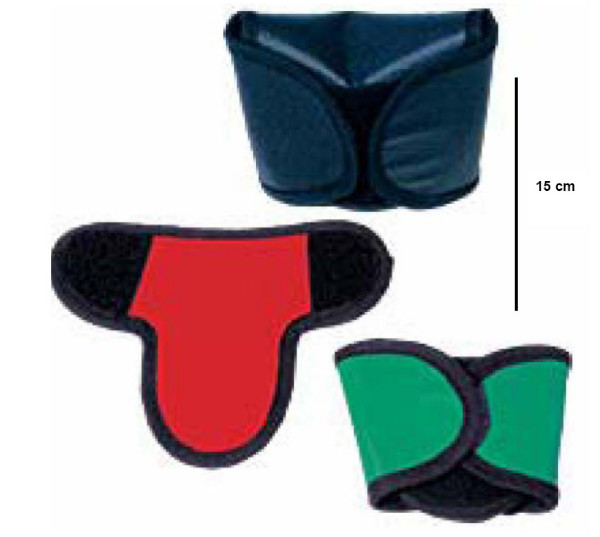
1 mm lead wrap-around gonad shields in three sizes. Flexible gonad protector, Dr. Goos-Suprema, Heidelberg, Germany.